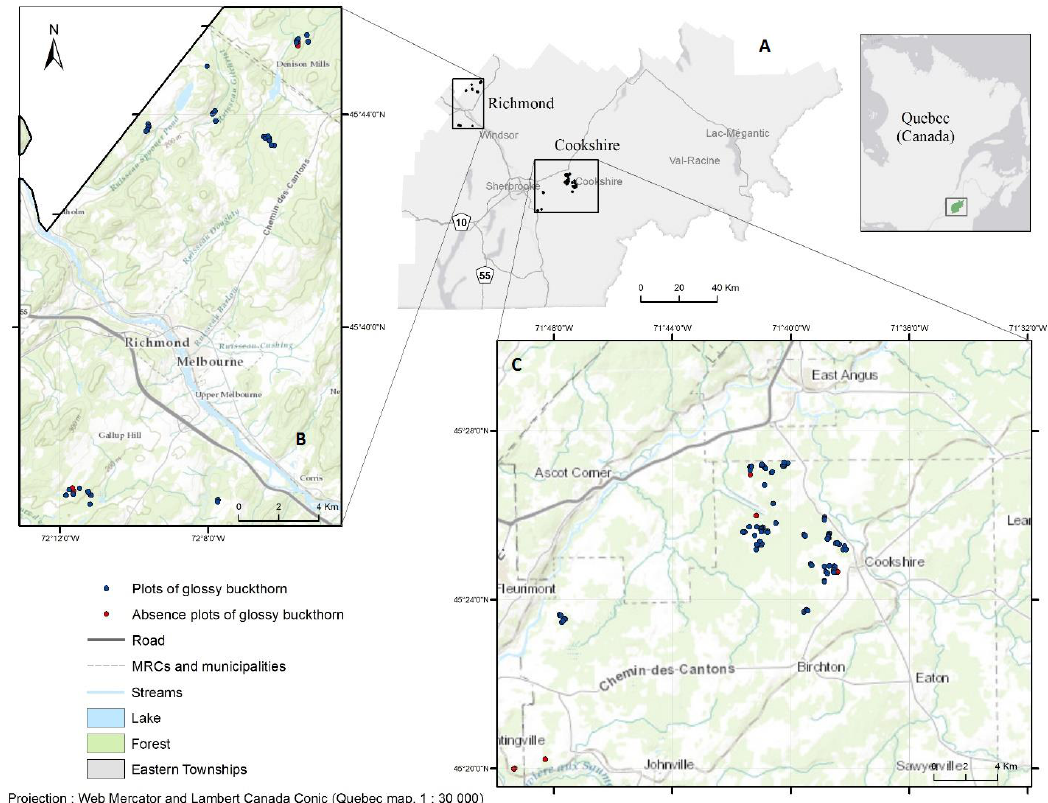
Figure 1. Study area ( A ) showing the two zones ( B : Richmond ; C : Cookshire ). The black rectangle in the upper right inset shows the location of the study area in southern Québec, Canada.